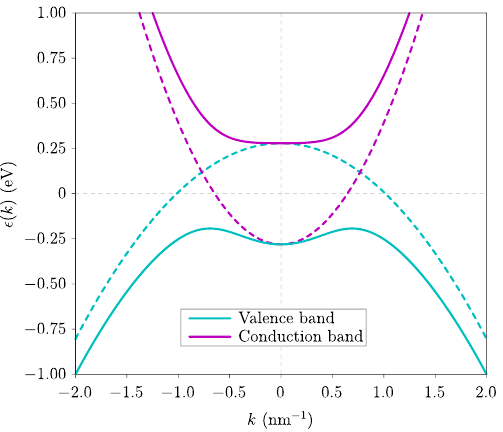
Figure 1. Band structure of two-dimensional Bi 2 Se 3 around the Ŵ point. Both the conduction bands and the valence bands are shown in solid lines. Each is two-fold degenerate, and due to spin-orbit coupling features a band inversion and an avoided crossing of the corresponding uncoupled states depicted with dashed lines. The dispersions are isotropic in the k · p approximation we are